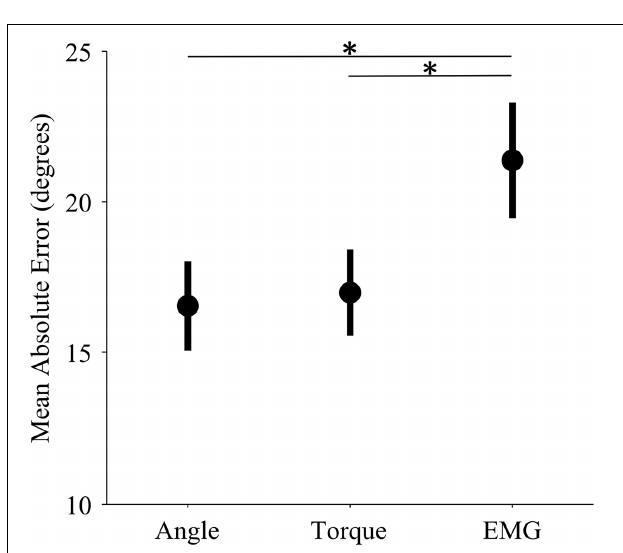
FIGURE 4 | Adaptation rates during each control modality and feedback condition. Blue squares and green crosses represent the mean adaptation rates across subjects for one dot and five dot feedback, respectively. Bars represent standard errors of the mean. of the adaptation curve and feedback uncertainty affected the intercept.